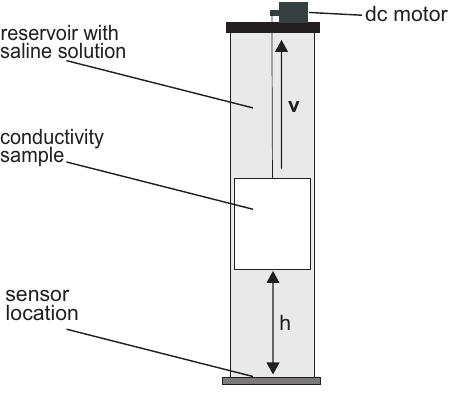
, and the corresponding tissue types. All values apply sample